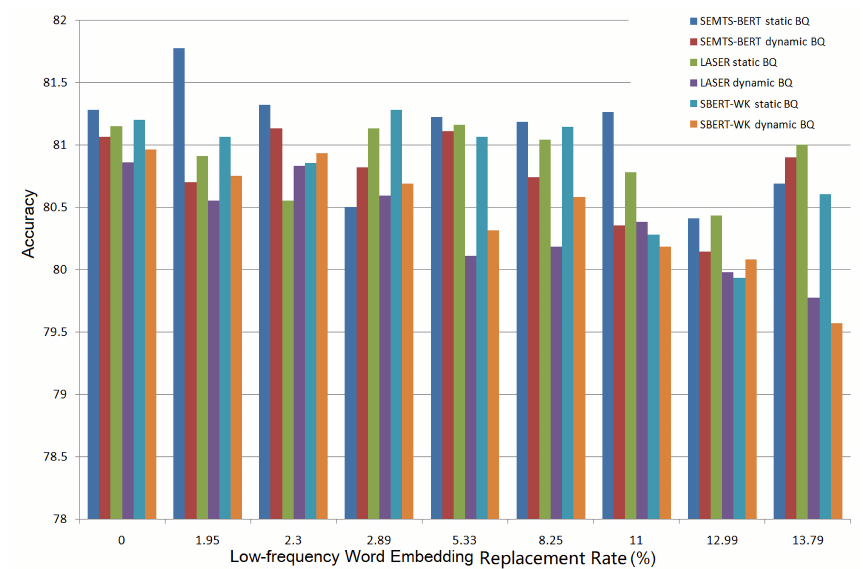
Figure 11. The influence of different low-frequency word embedding replacement rates on the performance of BiMPM evaluated on BQ.